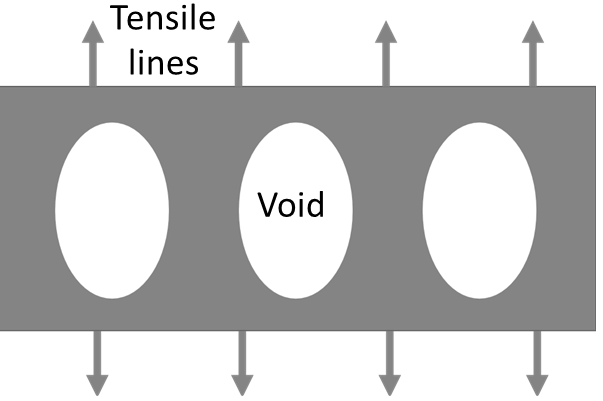
Figure 2. Tensile lines that influence the growth of voids (adapted from Anderson, 2017 [12]).